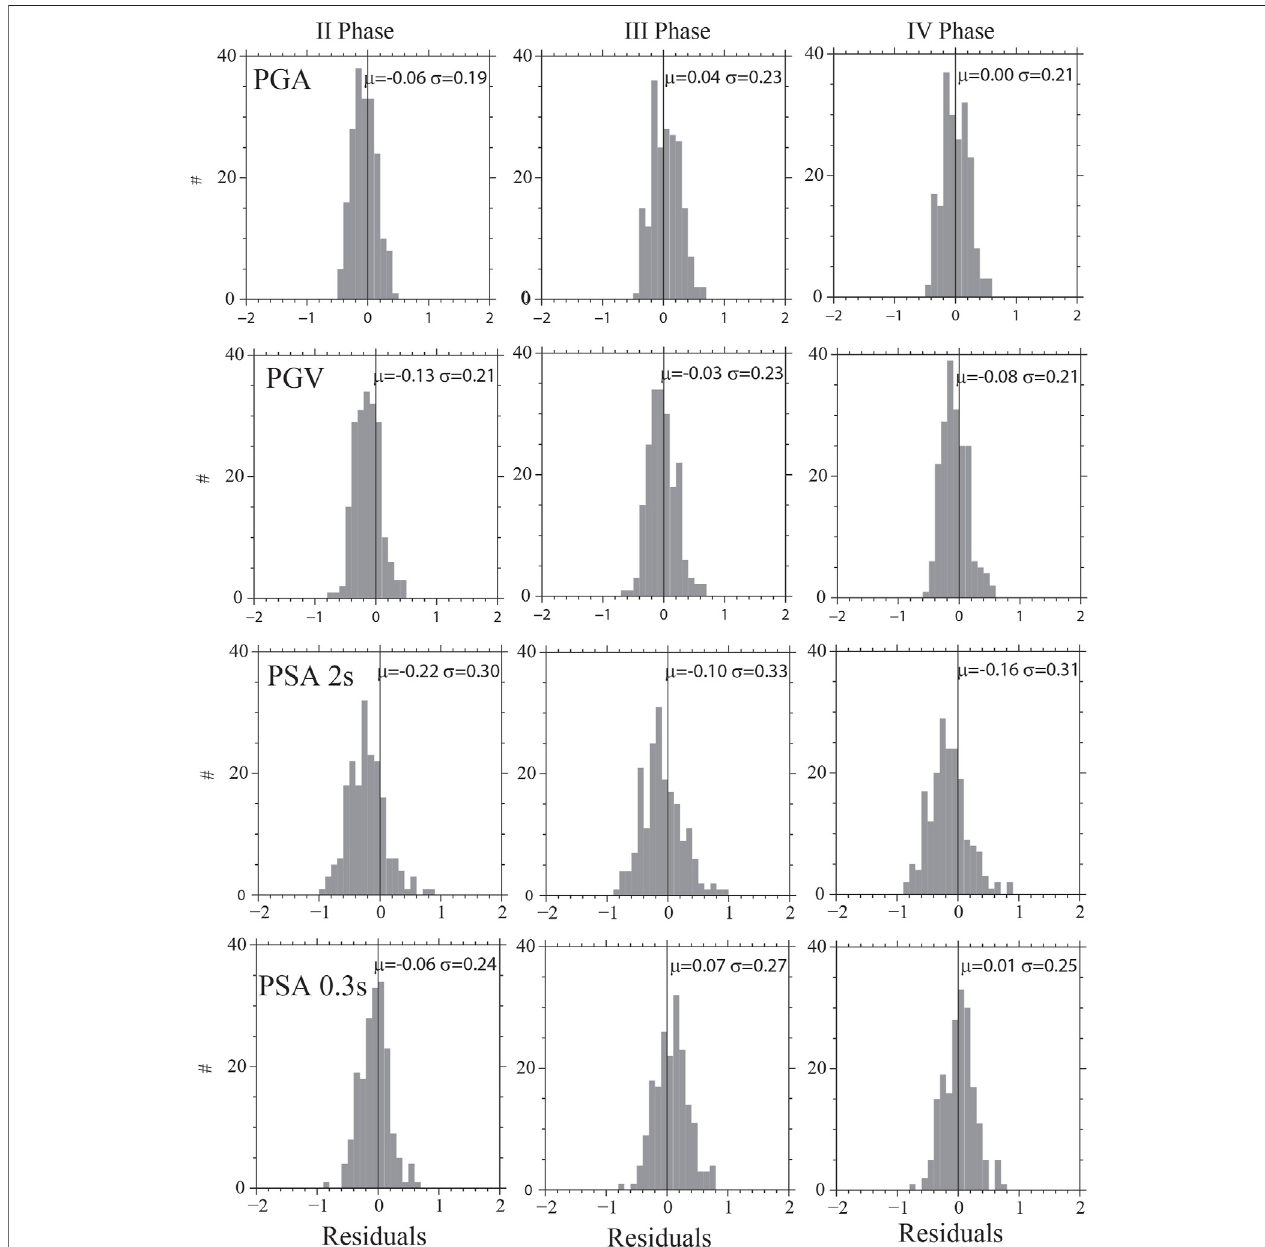
FIGURE 8 | Residuals (observed-predicted) of PGA, PGV, and PSA at 0.3 and 2 s calculated for the M6.3 Norcia earthquake. To predict the earthquake-induced ground motion, we used attenuation parameters obtained using the dataset belonging to phases II, III, and IV of the seismic sequence based on a stochastic fi nite-fault dynamic corner frequency